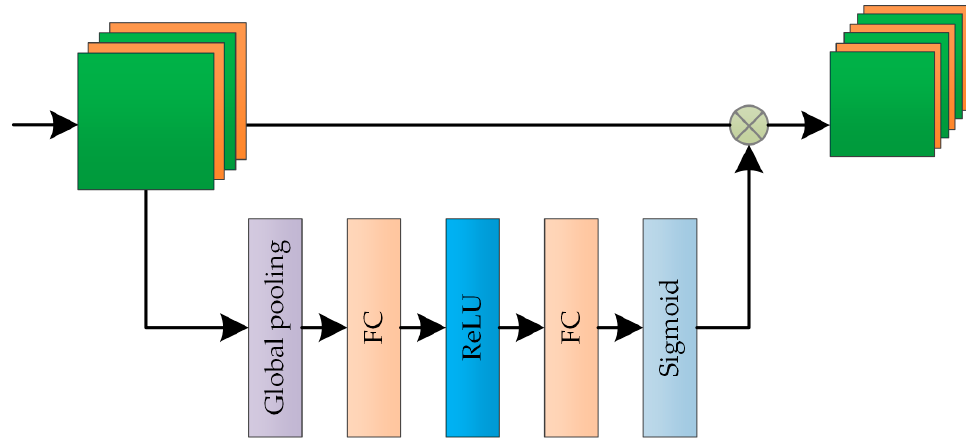
Figure 5. The structure of the channel attention module.